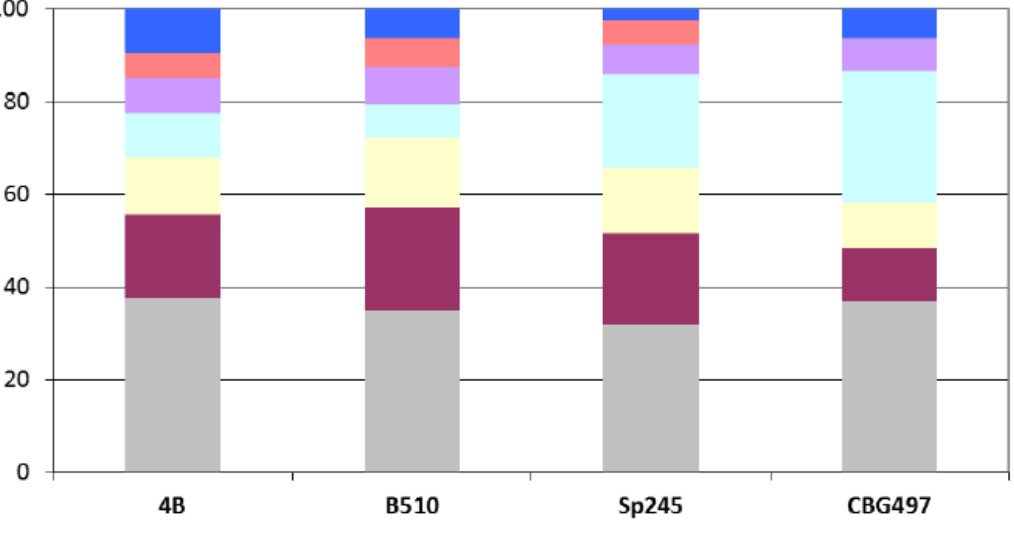
Figure 2. Repartition among replicons of Azospirillum unique proteins. Color legend: Grey (chromosome), burgundy (p1), yellow (p2), light blue (p3), purple (p4), orange (p5), dark blue